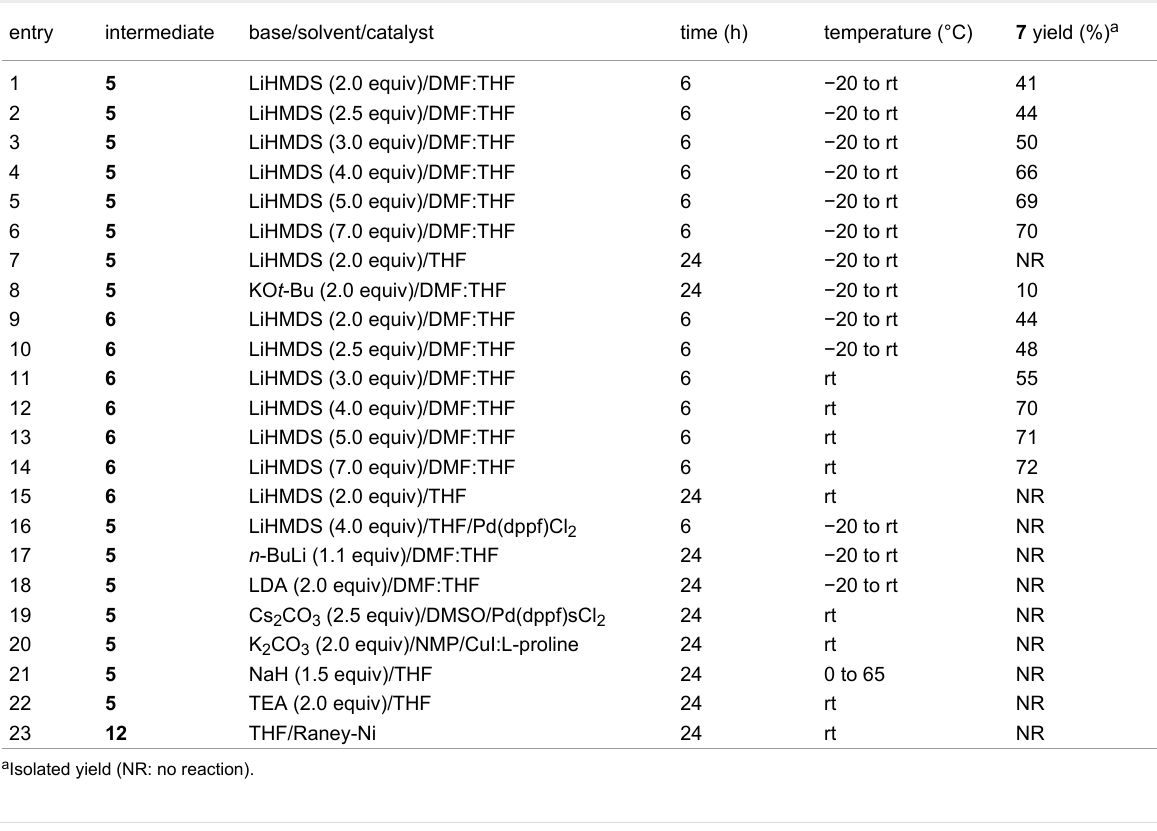
Table 2: Conditions for regioselective N -alkylation of naphthylethylsulfinamide 4a .